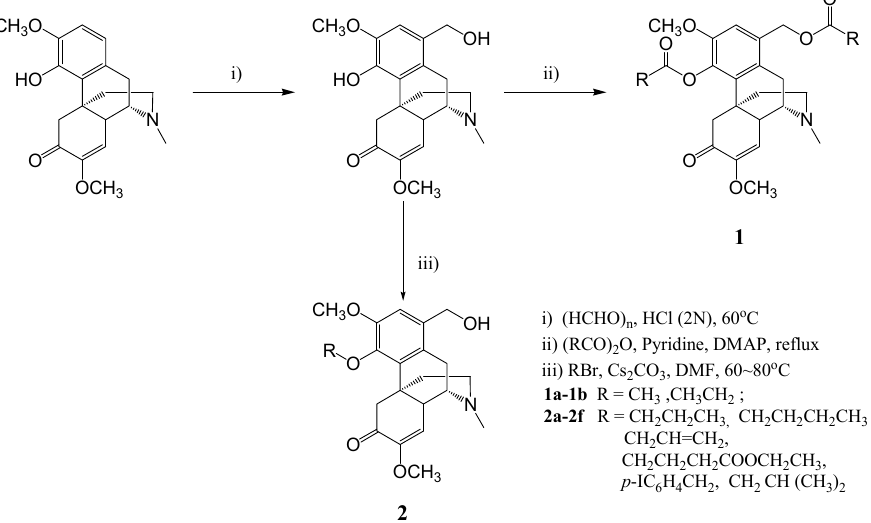
Figure 2. Route of synthesis for sinomenine derivatives.